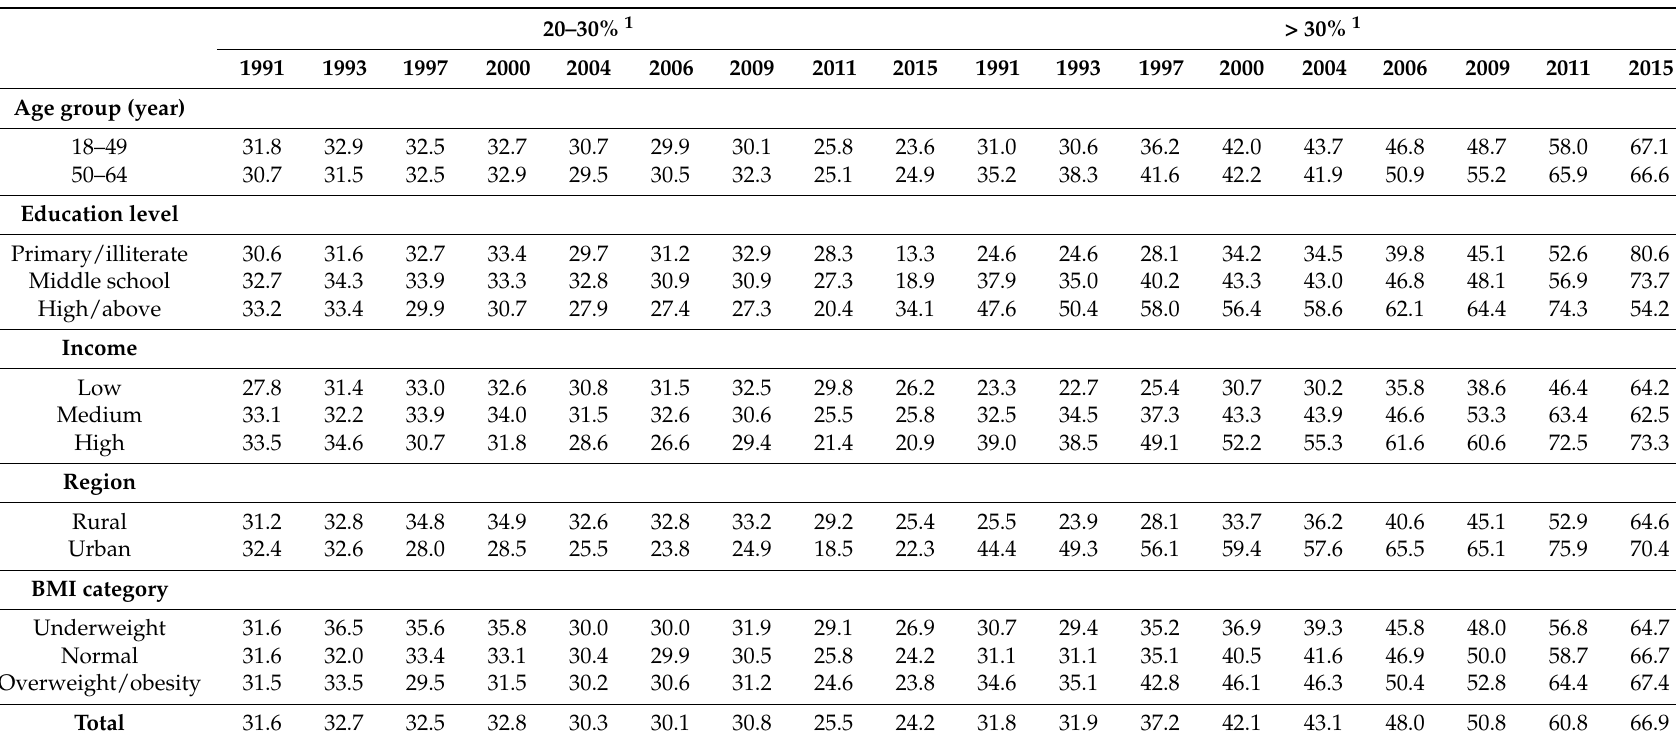
Table A1. Energy from fat compare to the DRIs standard in Chinese female adults from 1991 to 2015 2